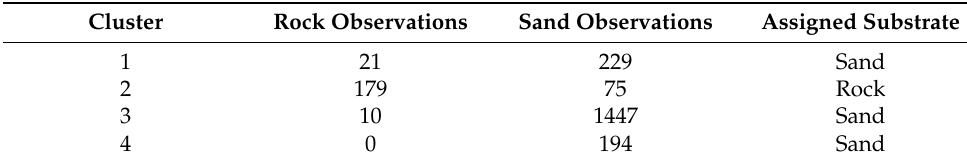
Figure 8. Plot of the percent of variance explained by each individual principal component for observed data and simulated data in which the variance was distributed randomly amongst the principal components as modeled by a broken-stick distribution. Table 3. Substrate interpretation of the map of the four acoustic clusters of the Elbow determined through k -means clustering (Figure 10a) using the ground-truth habitat observations from towed video in the training set (Figure 4a). The number of ground-truth points of each substrate type within an acoustic cluster were counted, and the acoustic cluster was assigned a substrate type based on the class of the majority of the images contained within that acoustic cluster.